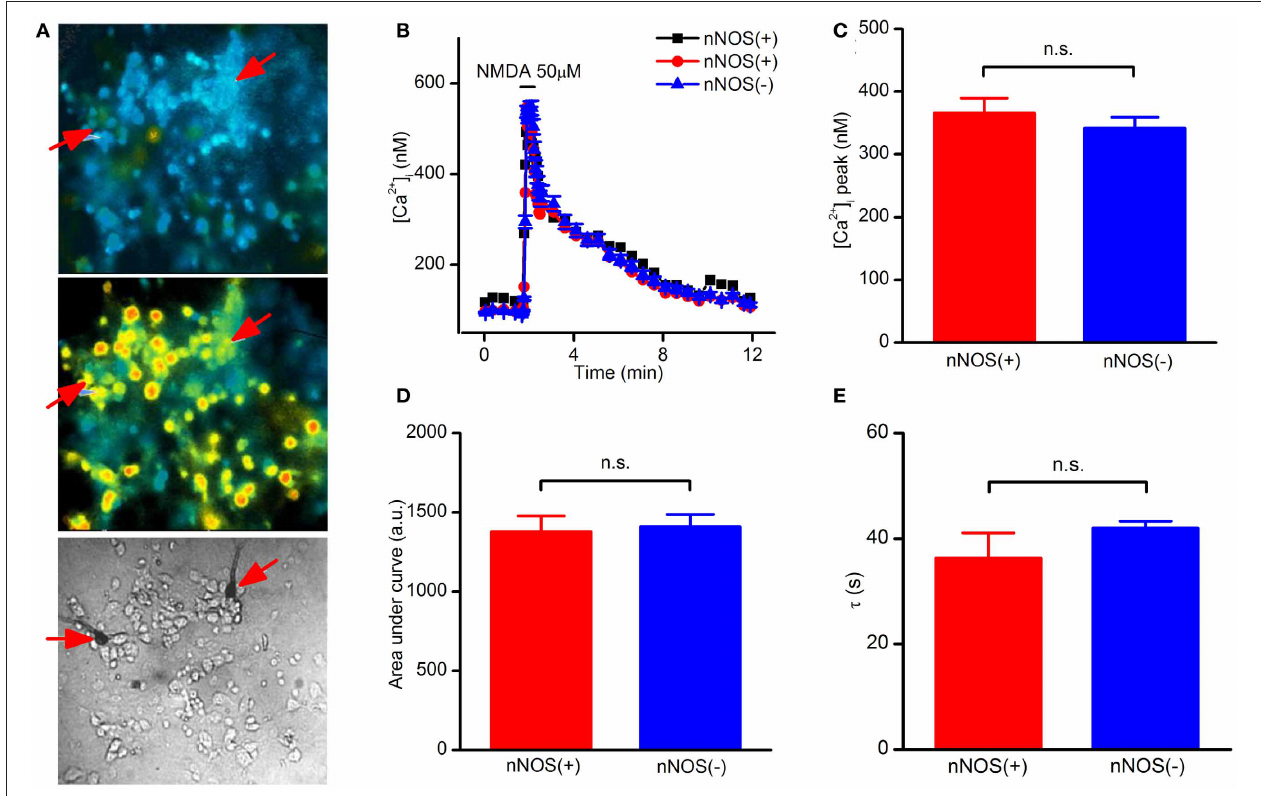
( n = 2) and nNOS( − ) ( n = 47)], representative of 20 independent experiments. (C) Average [Ca 2 + ] i peak amplitude in the two neuronal populations ( p = 0 . 42). (D) [Ca 2 + ] i dynamics expressed as area under the curve ( p = 0 . 70). (E) Recovery phase following NMDA exposure ( p = 0 . 43). Results are expressed as mean values ± SEM; nNOS( + ) n = 22; nNOS( − ) n =